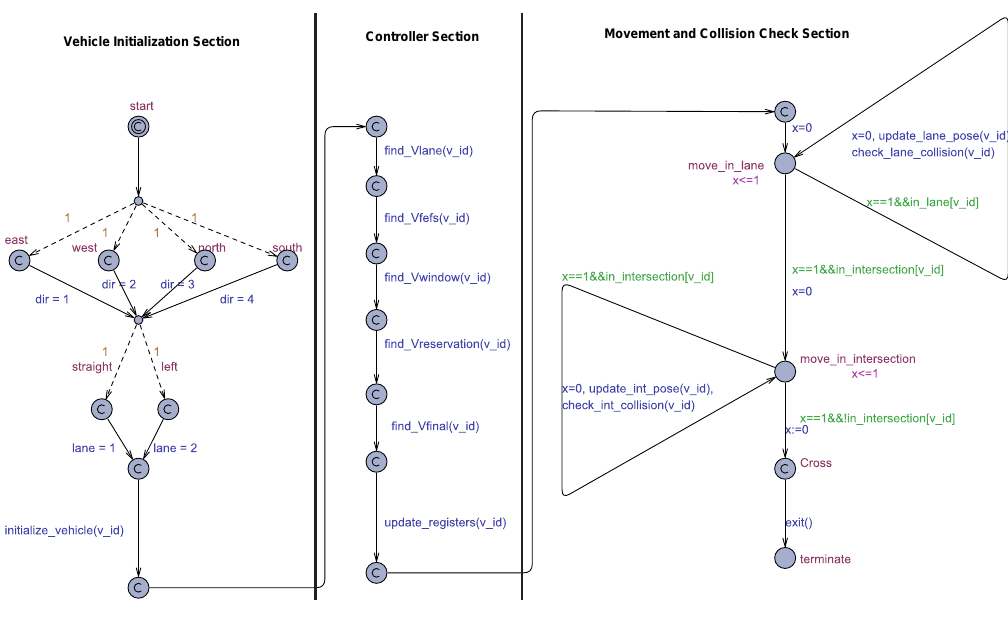
Figure 5. Master